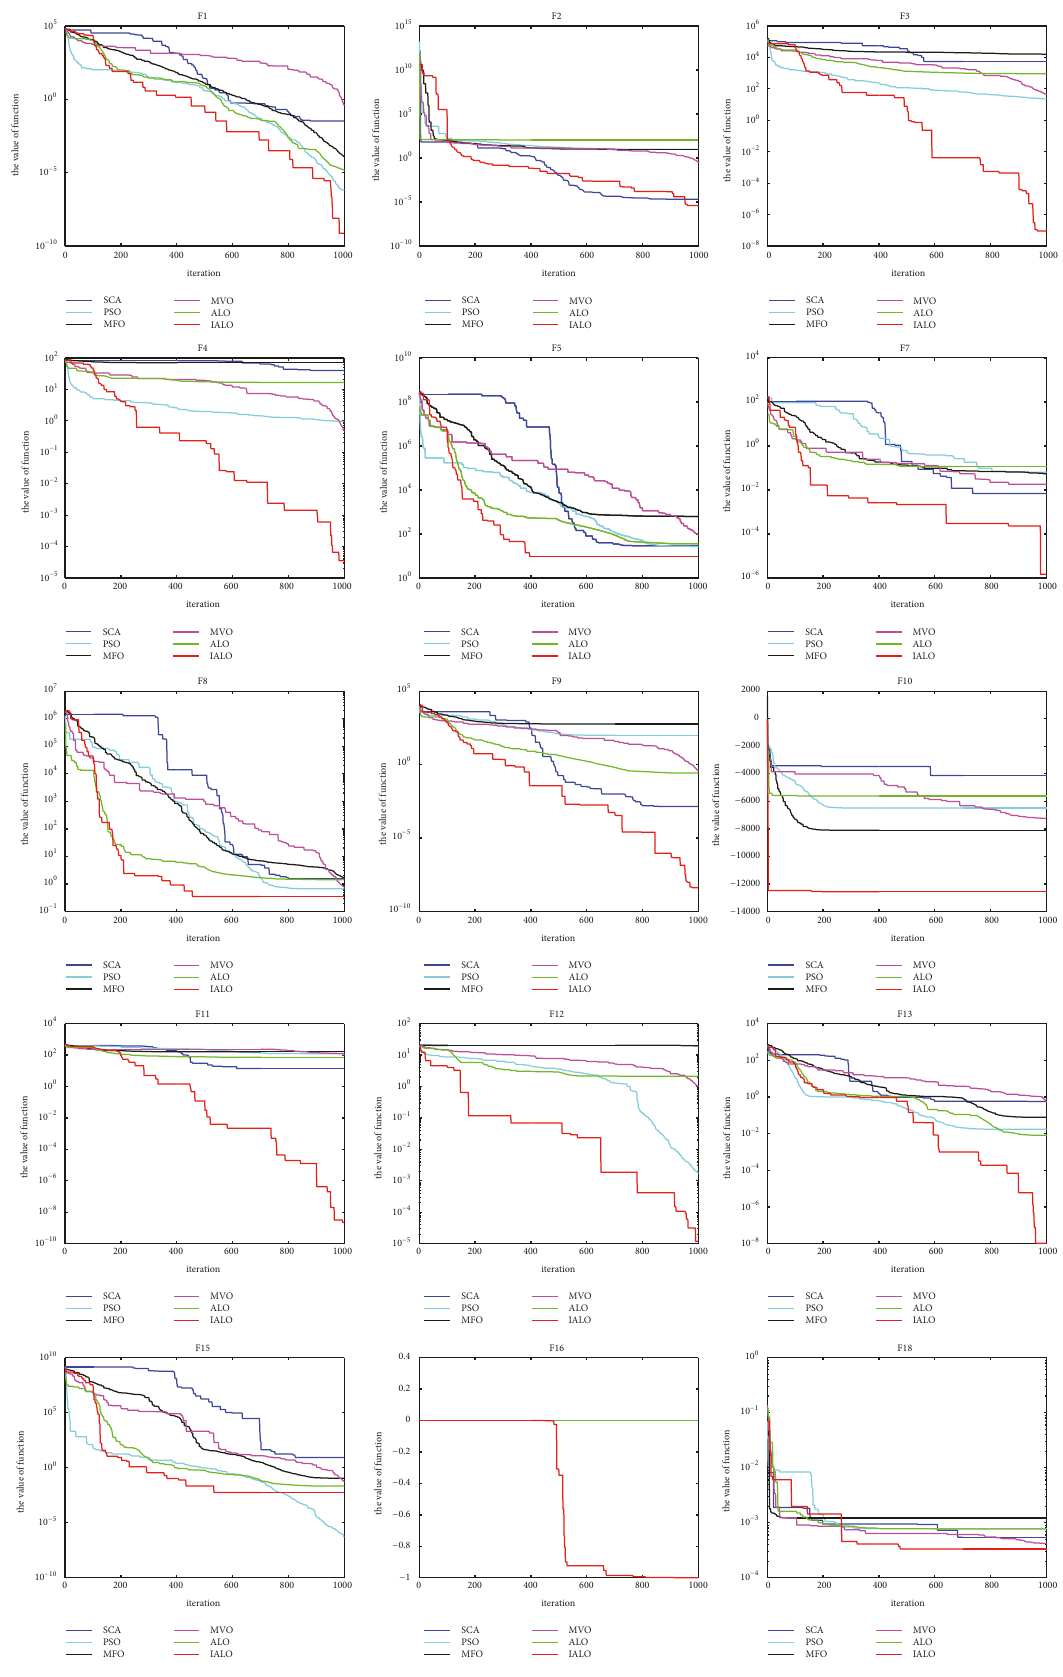
Figure 3: The convergence curves of some